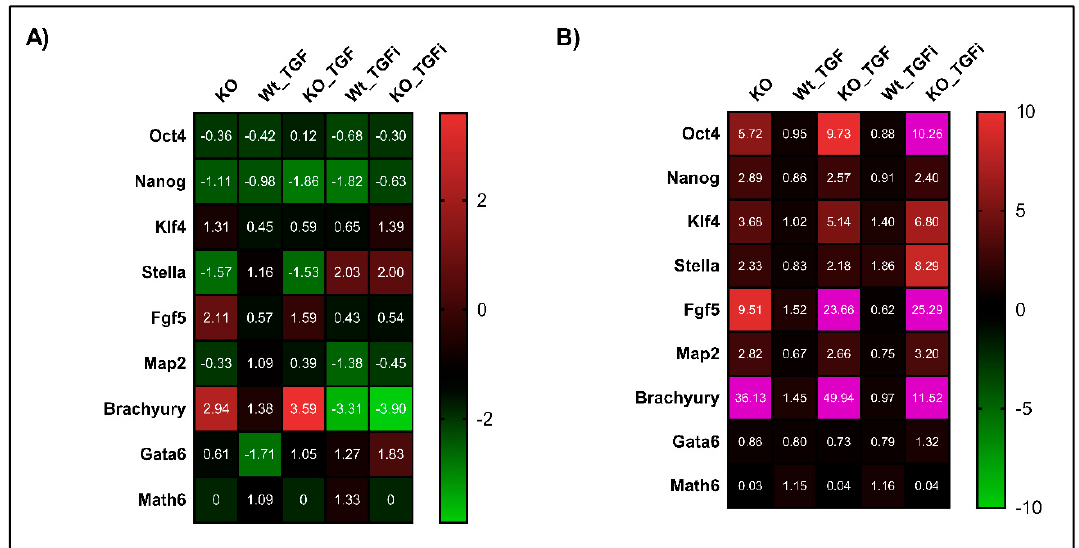
Figure 6. Math6 counteracts TGF- β signalling to restore naive pluripotent state. ( A ) Expression of pluripotency markers ( Oct4 & Nanog ), primed state markers ( Klf4, Stella and Fgf5 ) and differentiation markers ( Map2, Brachyury and Gata6 ) and Atoh8 in KO-iPSCs, WT-iPSCs treated with TGFb1, KO-iPSCs treated with TGFb1, WT-iPSCs treated with SB-431542 and KO-iPSCs treated with SB-431542. The gene expression shown is normalized to 18s and relative to WT-iPSCs. ( B ) Expression of pluripotency markers, primed state markers and differentiation markers in KO-ESCs, WT-ESCs treated with TGFb1, KO-ESCs treated with TGFb1, WT-ESCs treated with SB-431542 and KO-ESCs treated with SB-431542. The gene expression shown is relative to 18s and normalized to WT-ESCs. The gene expression data showing more than 10-fold are depicted in pink in the heat map.